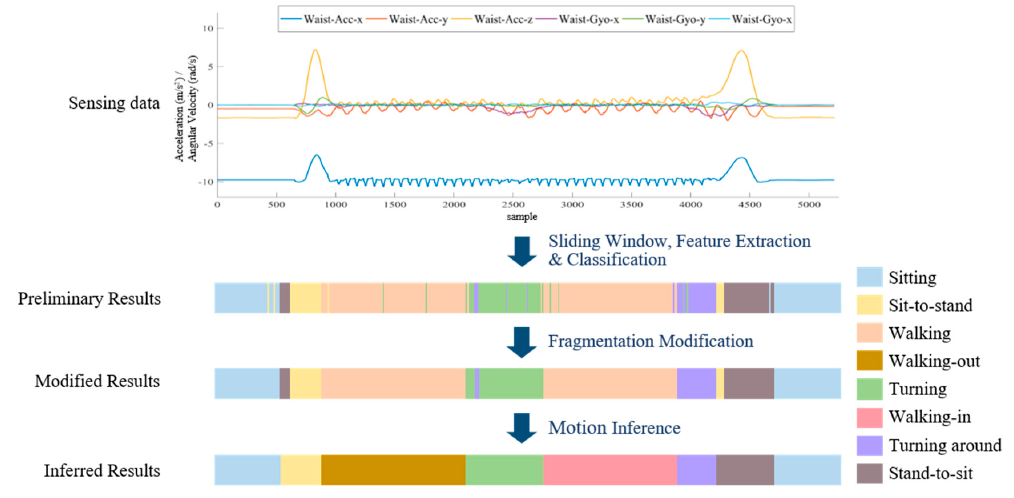
Figure 5. An example of the modified and inferred results.